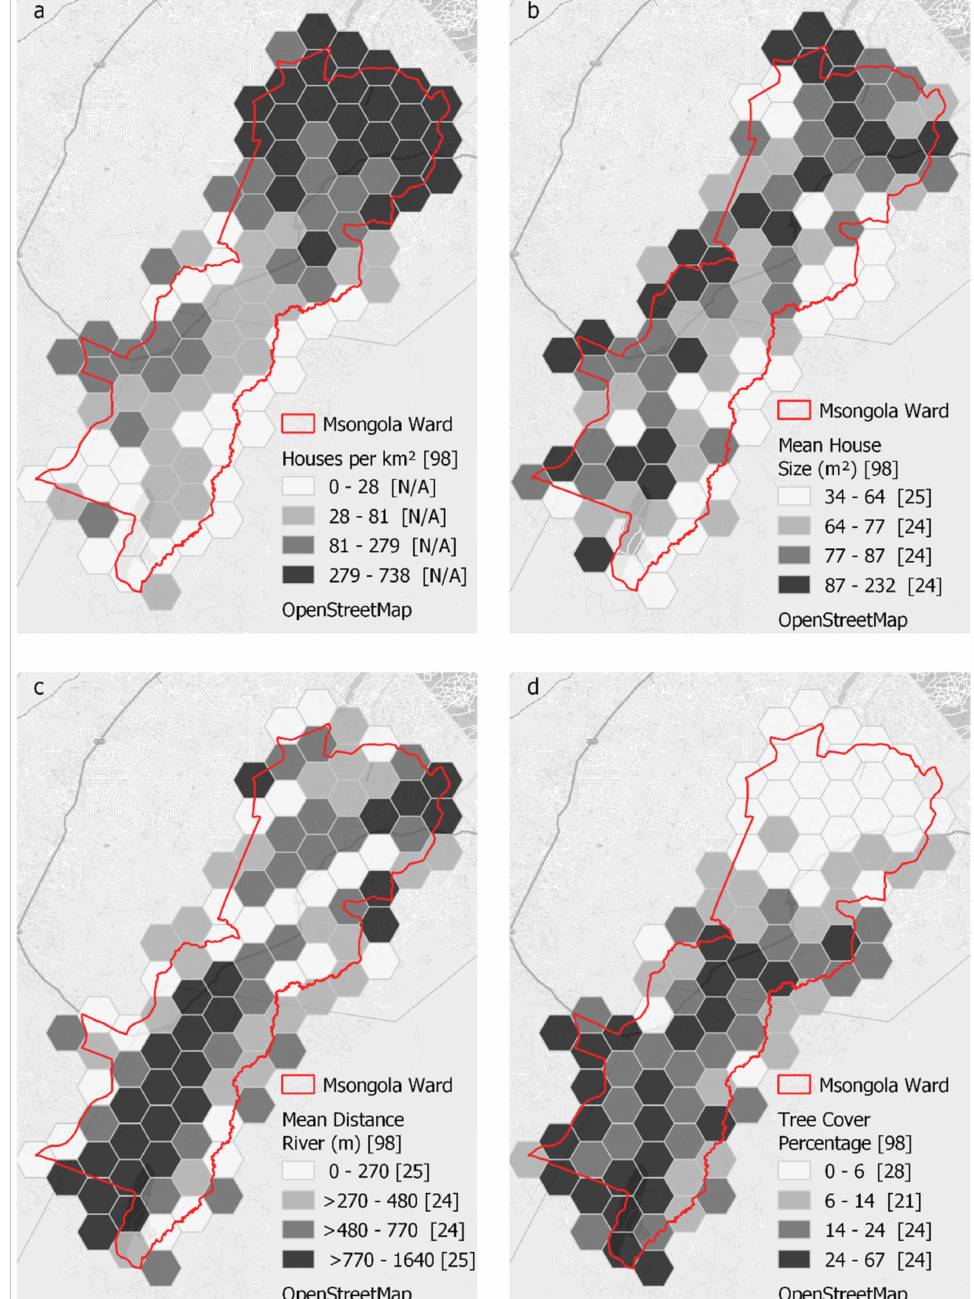
Figure 6. Maps of peri-urban spatial characteristics in four categories: ( a ) decreasing with distance to city center, ( b ) constant, ( c ) random, and ( d ) increasing with distance to city center (central business